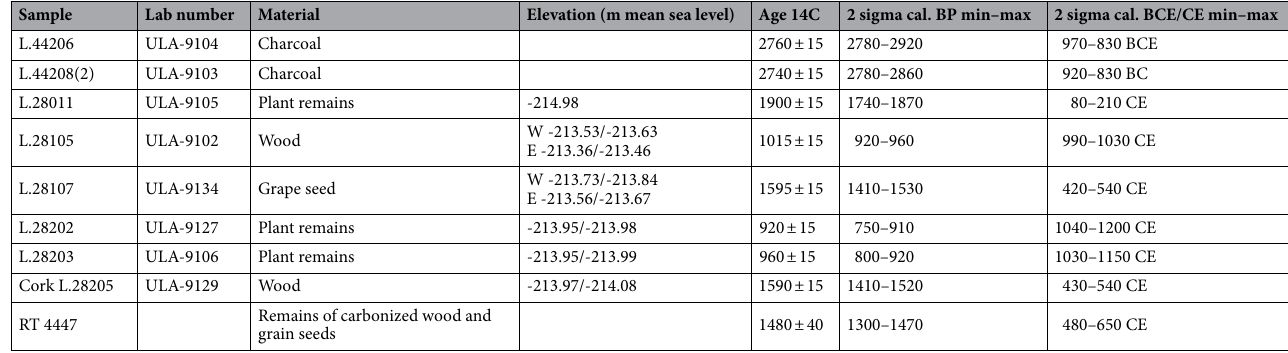
Table 1. AMS-14C data expressed in calibrated years BP and BCE/CE at the 95% confidence level (2σ). We used Calib 8.2 46,47 and the IntCal20 curve 48 . Sample RT 4447 from Galili et al. 45